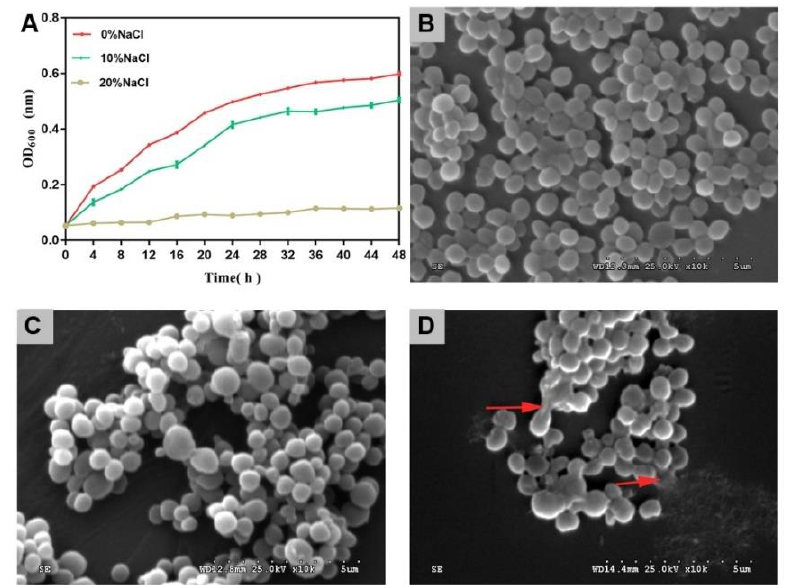
Figure 1. Cell growth and SEM images of S. aureus during salinity changes. ( A ) Growth curves. The error bars indicate the standard deviation (N = 3). ( B ) SEM image of S. aureus in control group. ( C ) SEM image of S. aureus in 10% NaCl group. ( D ) SEM image of S. aureus in 20% NaCl group. ×10K-fold.